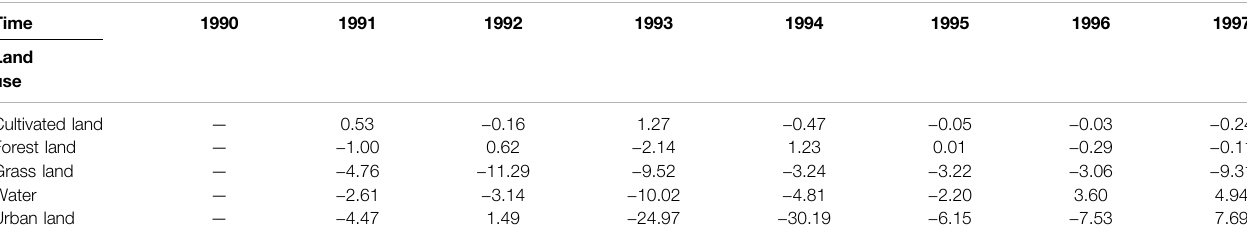
TABLE 3 | Rates of change of land use of the study area from 1990 to 1997.